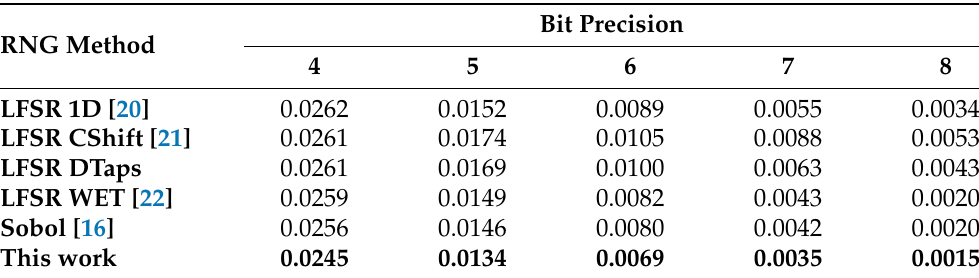
Table 6. MAE for different RNG circuits evaluated for different bit-precision in the Roberts edge detection circuit. The best result of each column is highlighted in